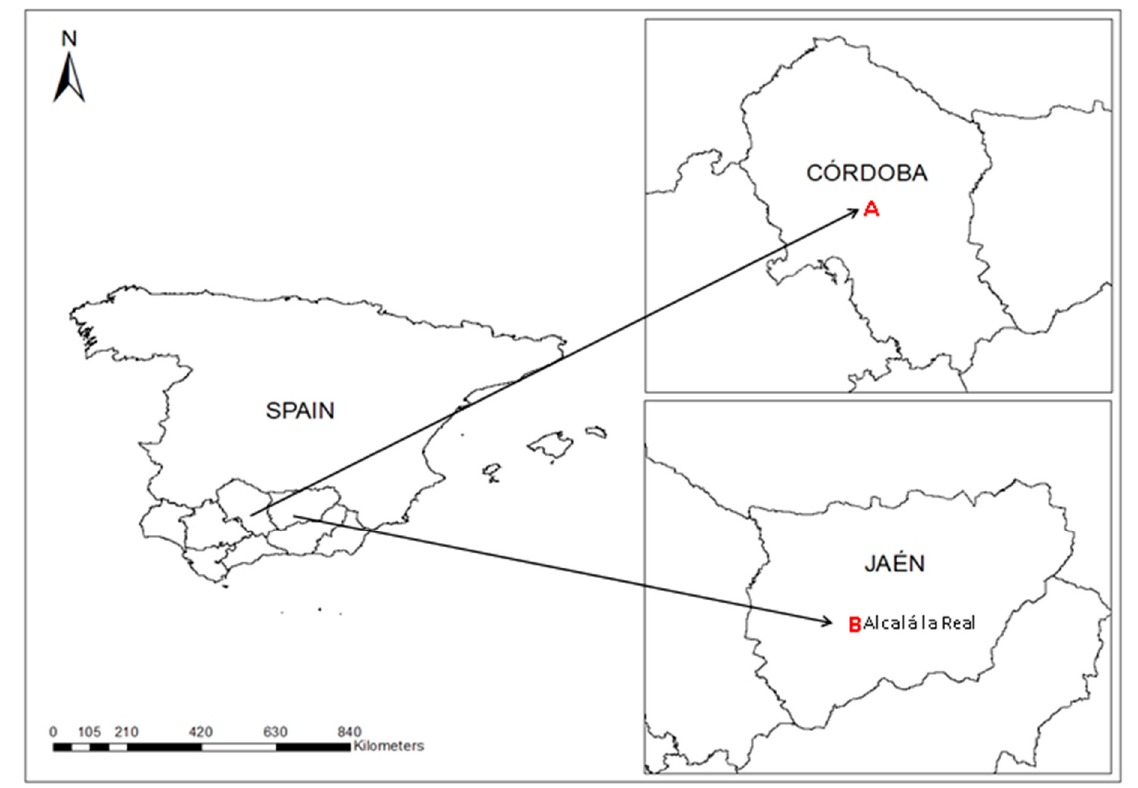
Figure 1. Location of two experimental farms in the southern Spain.